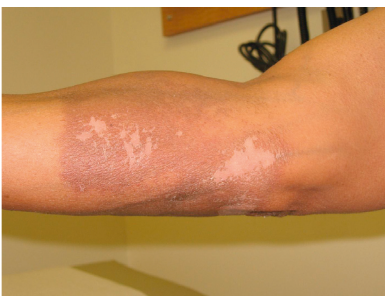
Figure 2: RRD demonstrated on previously irradiated area of the right forearm. RRD, radiation recall dermatitis. Table 1: Radiation recall dermatitis toxicity grading.